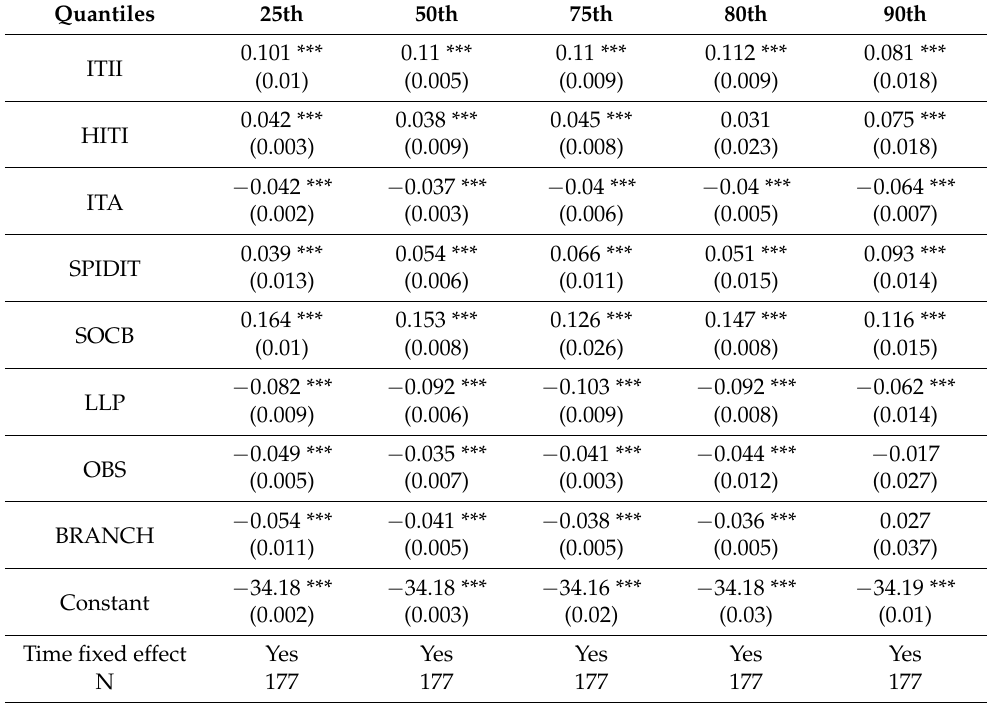
Table 4. The impact of ICT components on bank